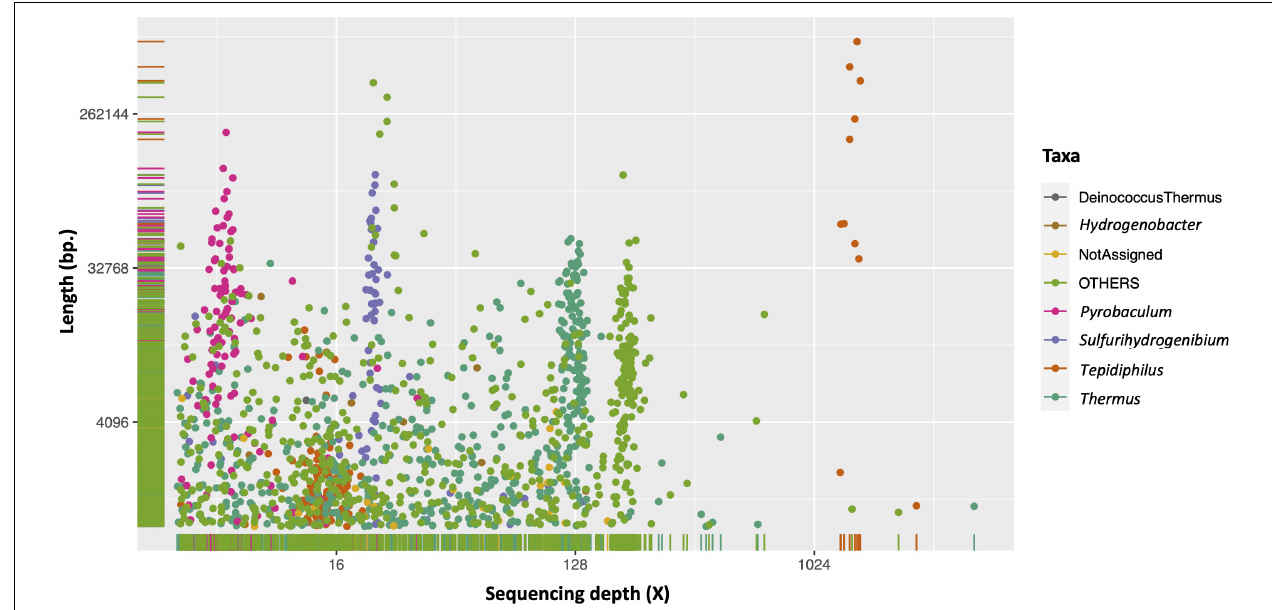
FIGURE 4 | Injection water metagenome analysis of scaffold depth, length, and taxonomy. The scaffold average sequencing depth (Depth, X -axis) and nucleotide size (Length, Y -axis) are plotted using log2 transformation. The color scheme represents the respective taxa assignment for each scaffold based on the MEGAN